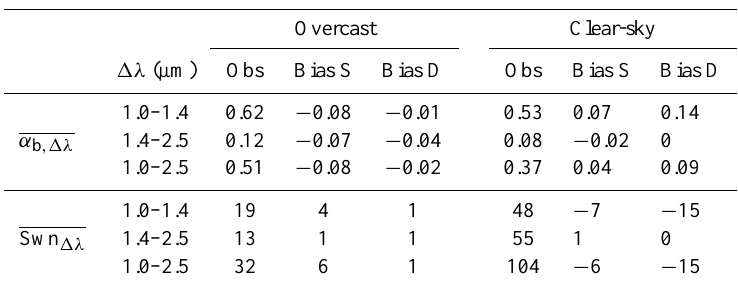
Table 5. Mean surface albedo ( α b ,(cid:49)λ ) and net shortwave radiation (Swn (cid:49)λ , Wm − 2 ) integrated over three distinct wavebands ( (cid:49)λ = 1 . 0– 1.4, 1.4–2.5, and 1.0–2.5µm) during overcast and clear-sky conditions. “Obs” refers to values obtained using the reflectance-derived albedo, “Bias S” and “Bias D” are the mean biases between model- and reflectance-derived integrated quantities obtained using spheres and droxtals,